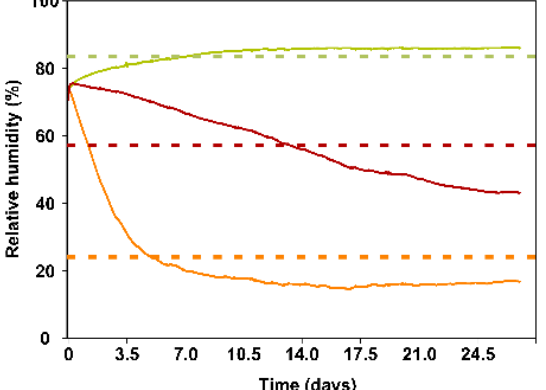
Figure 1. Temporal variation in the RH inside the slow-release mite sachets (solid lines) when they were maintained at three values of ambient RH, namely, low (22.5 ± 2.5%) (orange), medium (52.5 ± 2.5%) (red) and high (87.5 ± 2.5%) (green) (dotted lines), and at a constant temperature (25 ± 1 °C) under laboratory conditions.